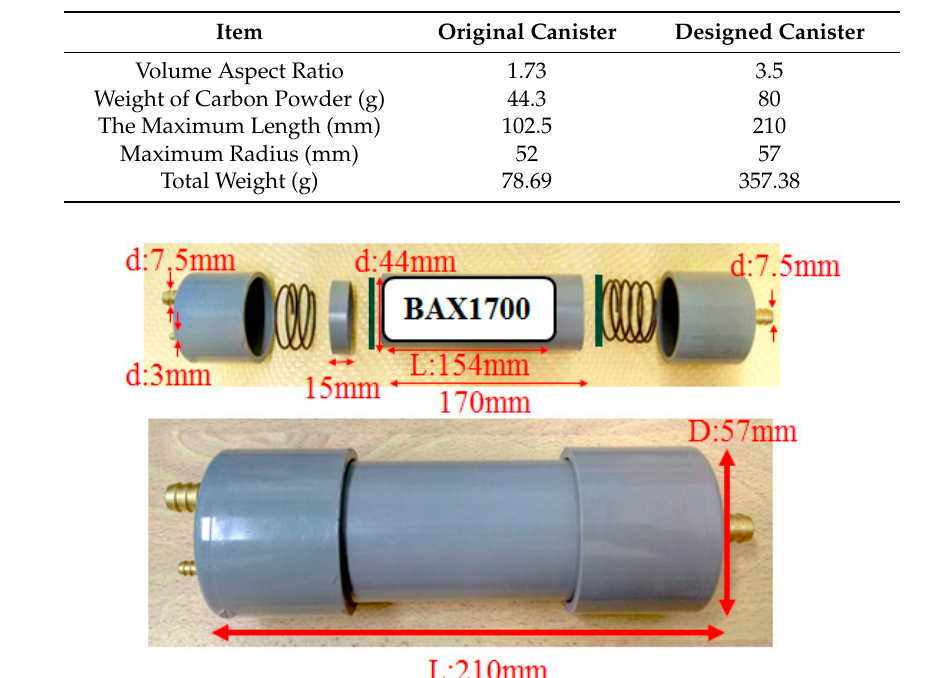
Figure 5. Exploded view of the self-made carbon